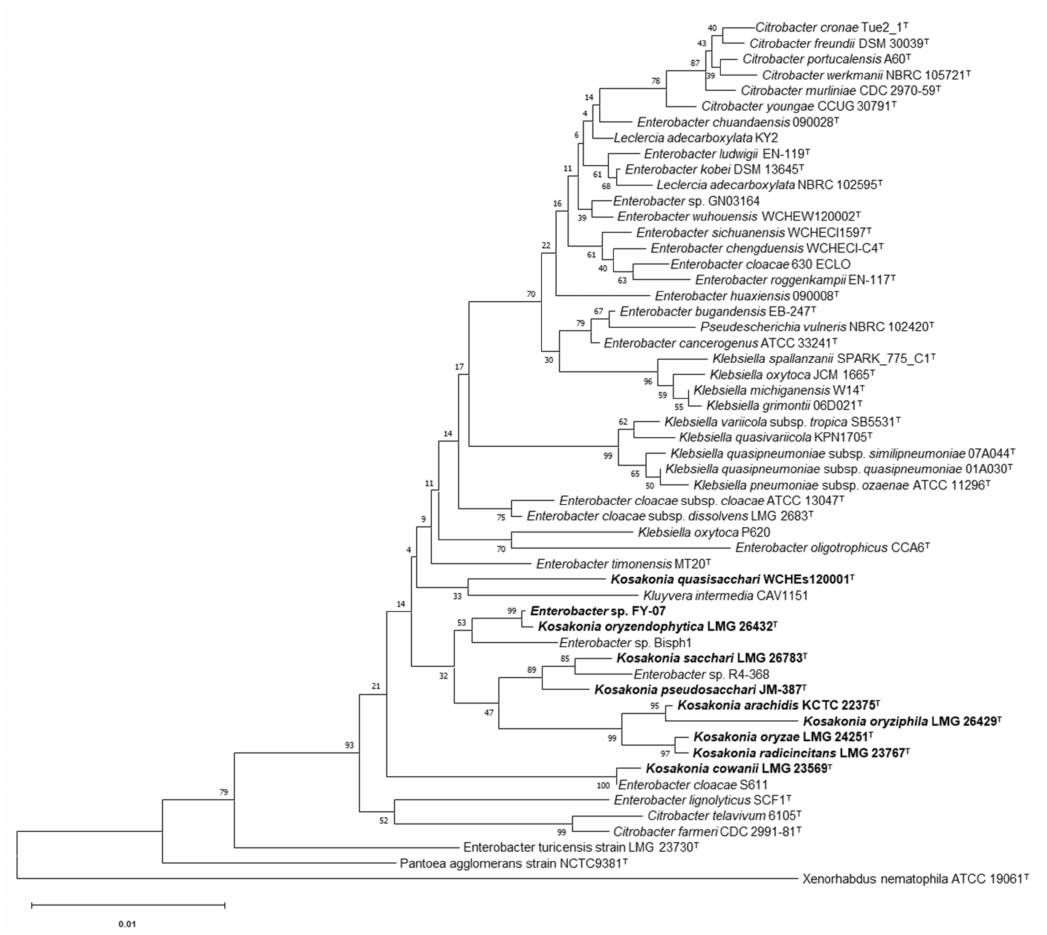
Figure 1. Neighbor-joining tree showing the 16S rRNA gene phylogenetic relationships of strain FY-07 and phylogenetically related reference strains. Bootstrap values based on 1000 resampling tests are shown at branch nodes. Bar, 1% substitution rate per